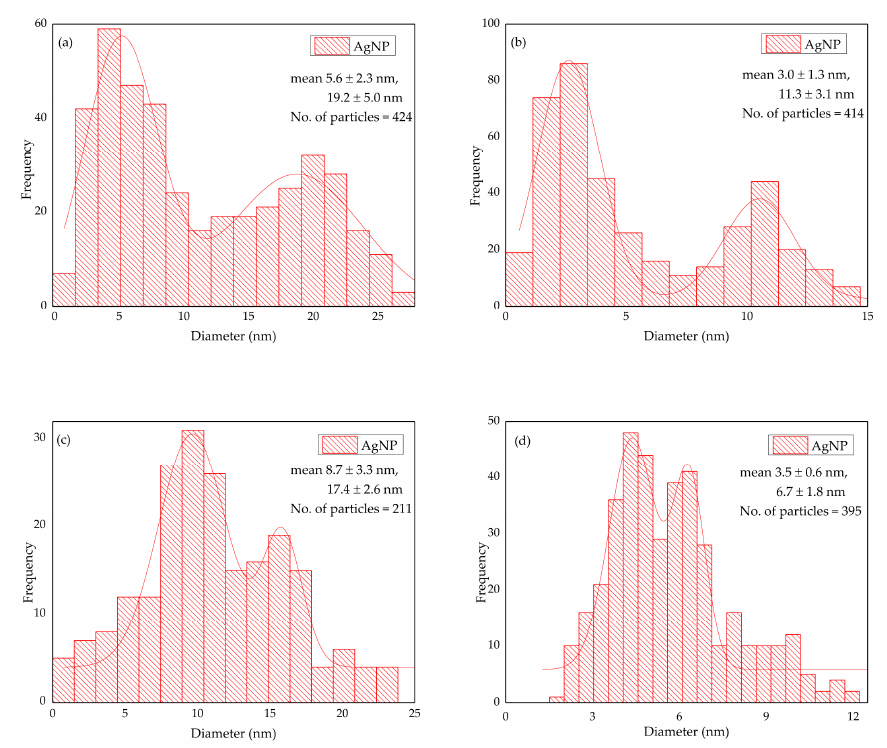
Figure 8. Particle size distribution of AgNPs produced by: ( a ) WLC-1.250 mM; ( b ) WLC-0.625 mM; ( c )